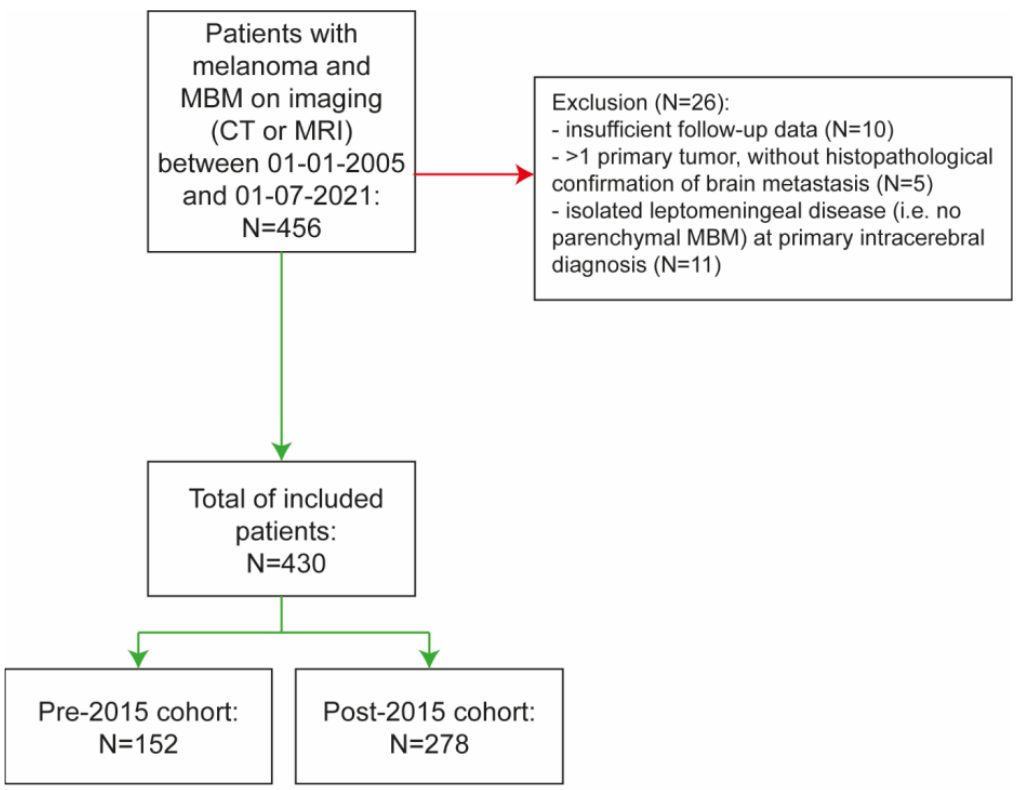
Figure A1. Flow chart of patient inclusion. Patients were subdivided into a pre-2015 cohort (diagnosis of melanoma brain metastasis (MBM) before 1 January 2015) and a post-2015 cohort (diagnosis of MBM after 1 January 2015). CT: computed tomography. MRI: magnetic resonance imaging.